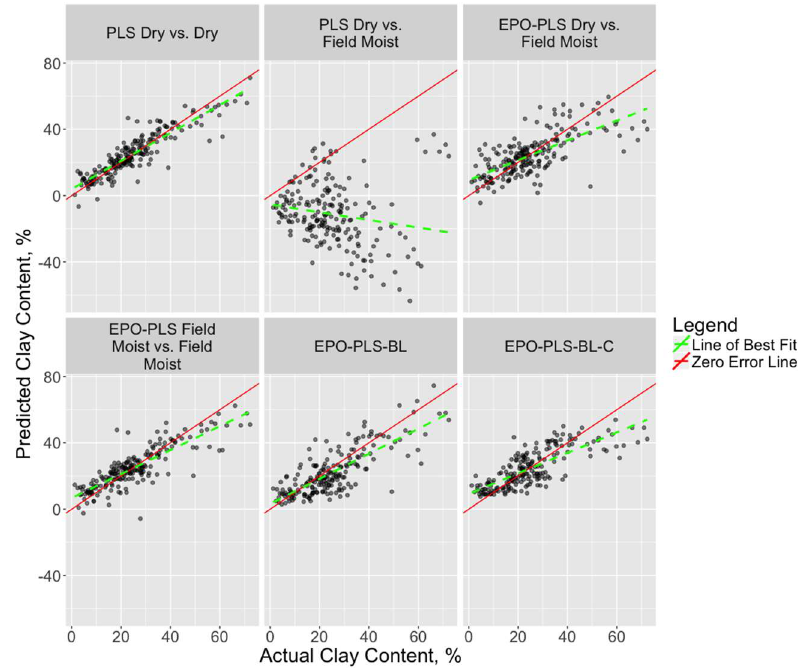
Figure 4. Scatterplots of actual and predicted values for the validation (test) dataset with clay content as the response. The red line represents the 1:1 (actual = predicted). For a perfect model, all points would fall on this line (zero-error line). The dashed green line represents the line of best fit for the points.